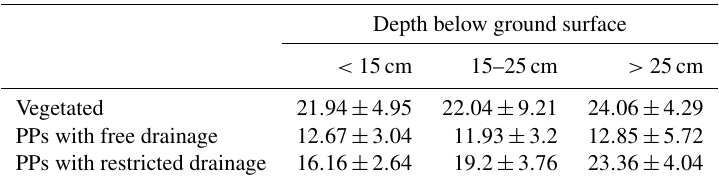
Table A2. Mean soil moisture (vol.%) measured at different plot categories and depths together with the mean standard deviation of each group.